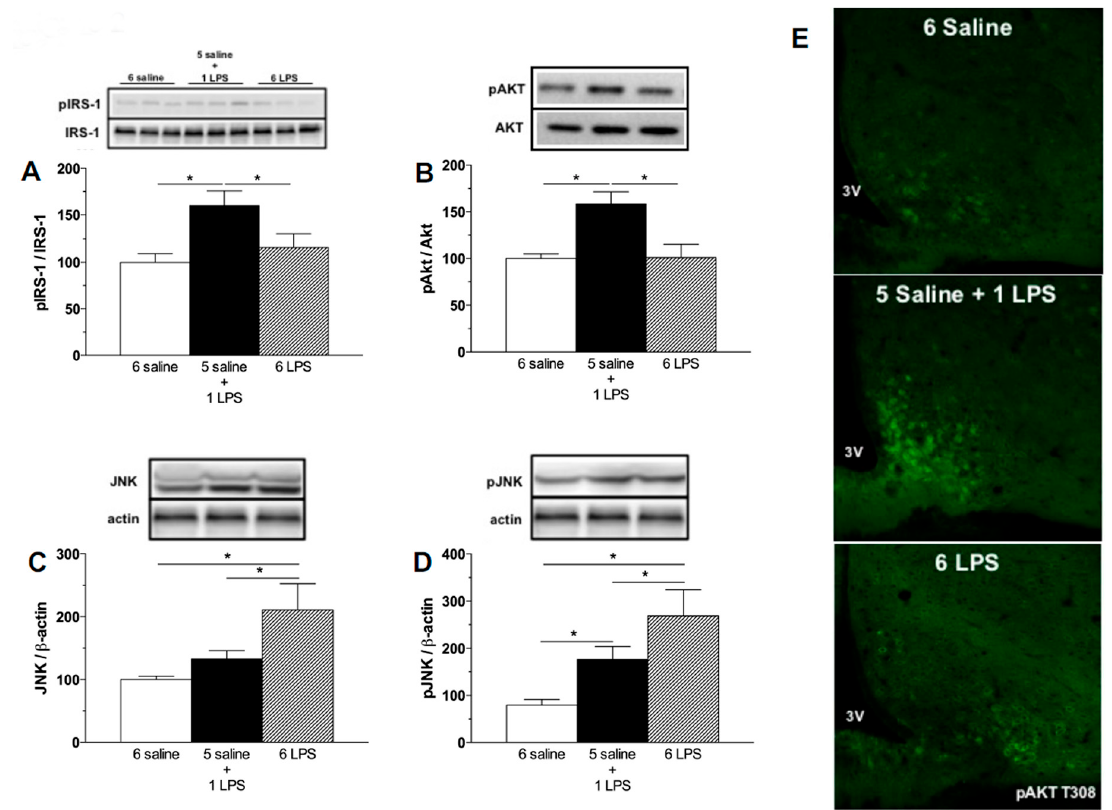
Figure 2. Acute endotoxemia increases phosphorylation of insulin signaling proteins whereas prolonged endotoxemia induces higher expression of the inhibitor of insulin cascade signaling, c-Jun N-terminal Kinase (JNK). Percentage of Phospho-Insulin receptor substrate-1 (pIRS1) ( A ), Phospho-Protein kinase B (pAKT) ( B ), JNK ( C ), and Phospho-c-Jun N-terminal Kinase (pJNK) ( D ) expression in the mediobasal hypothalamus of saline (6 saline), single (5 saline + 1 LPS, 100 ug/kg ip), or repeated LPS (6 LPS) treated-animals. The representative results of two independent experiments ( n = 6–8/group) are shown with the measurements performed with samples from the same animal. One-way ANOVA, followed by Fisher post hoc test was performed. Data are expressed as means ± SE. Differences were accepted as significant at * p < 0.05; ( E ) representative photomicrographs showing the pAKT T308 expression (green) in neurons from the arcuate (ARC) nucleus of the hypothalamus of animals treated with 6 saline, 5 Saline + 1 LPS, and 6 LPS injections. 3V, third ventricle. Objective: 40×.